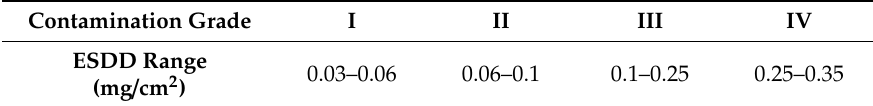
Table 2. Selection of ESDD for artificially contaminated insulators.